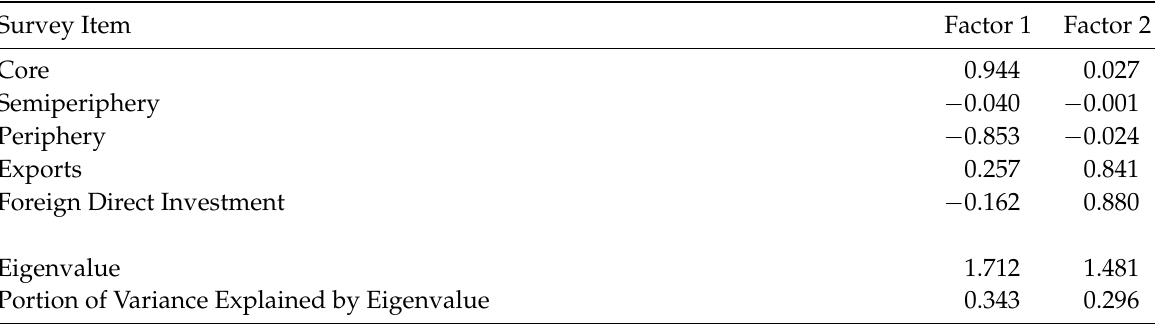
Table 2: Principal component factor analysis of world-system position. Survey